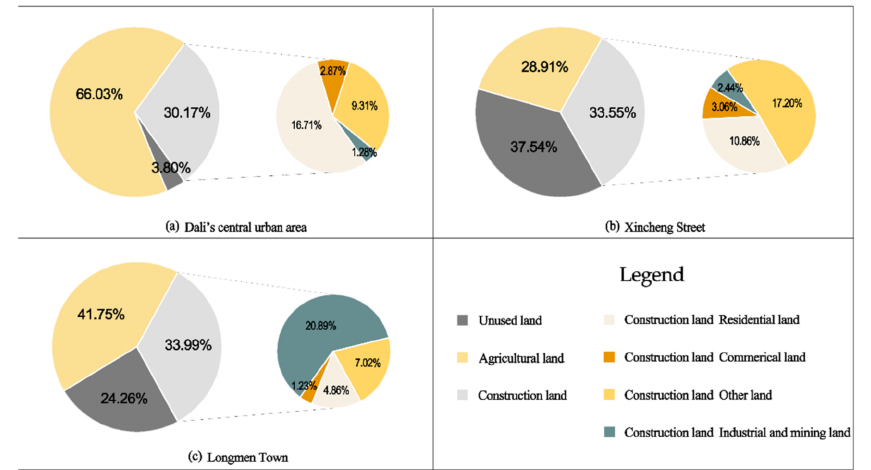
Figure 2. Classified statistical map of land survey in the study